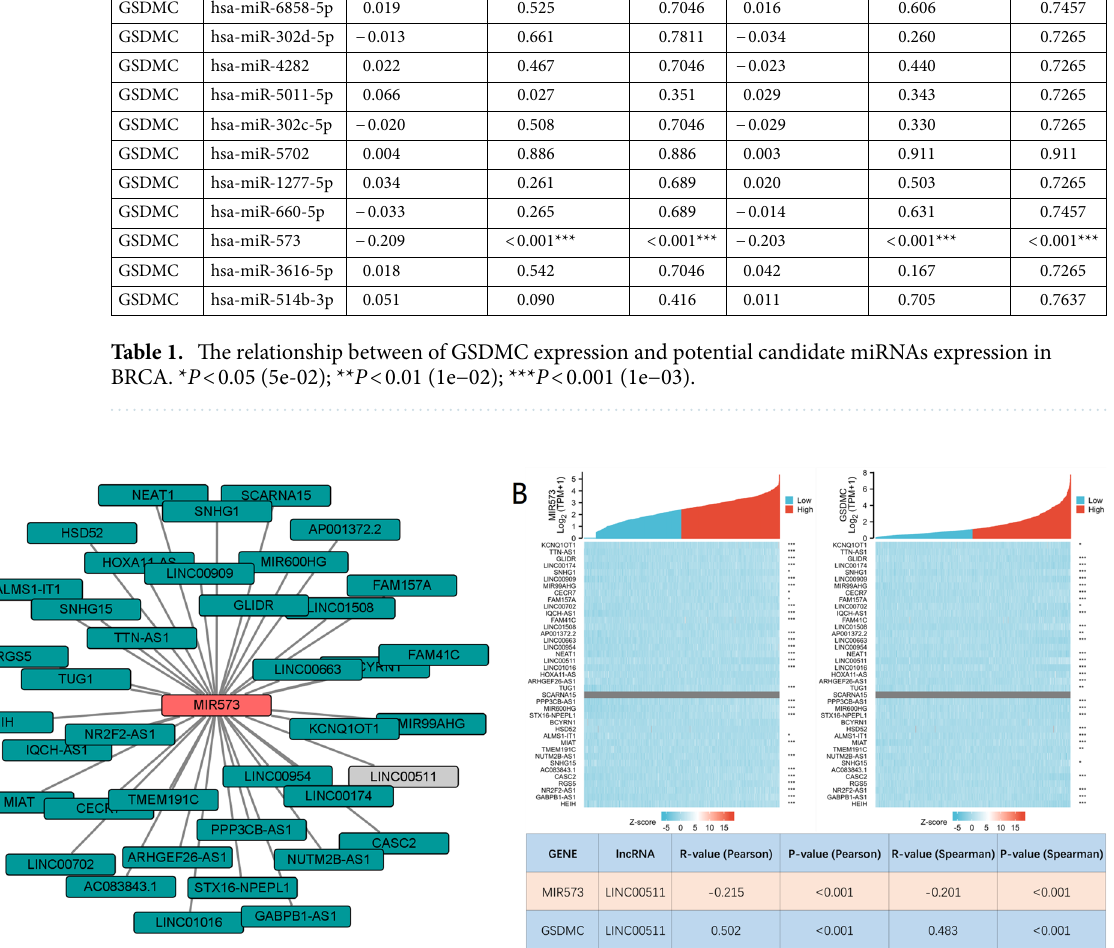
Figure 10. ( A ) lncRNA-hsa-miR-573 regulatory network; ( B ) correlation analysis of hsa-miR-573 expression and 39 lncRNAs in BRCA in TCGA database. * P < 0.05, ** P < 0.01, *** P <